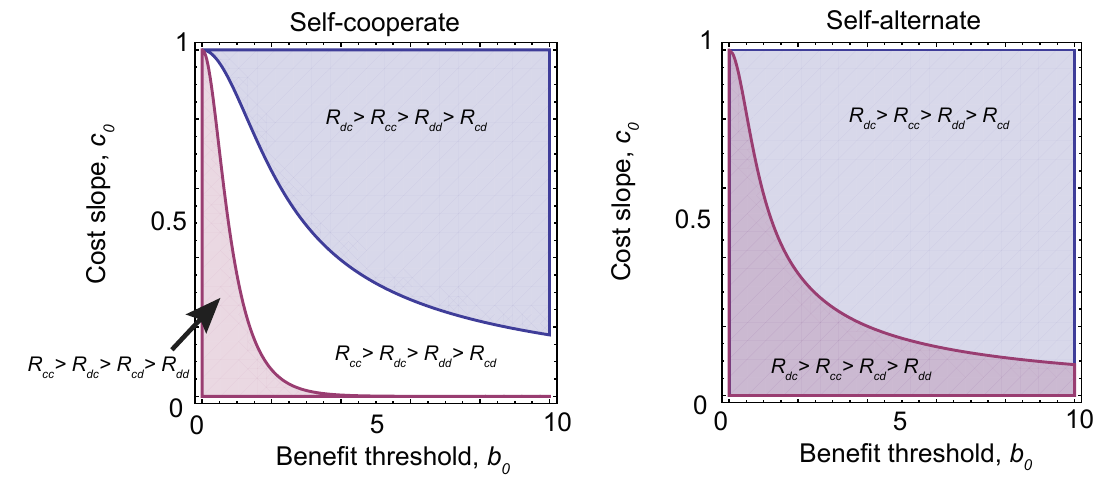
Figure 5. The evolution of different games. Under a sigmoidal benefit function (Equation (13)), different pairs of strategies and investment levels are robust (Equations (14) and (15)). Depending on the choice of threshold in the benefit function, b the rate of change of the cost of cooperation with investment, c slope of the sigmoid h = 4 ), this can result in different orderings of payoffs and, hence, different equilibrium games. (Left) The equilibrium games paired with self-cooperating strategies. The blue region has payoff ordering R a prisoner’s dilemma. However, in the white region R hunt game, and in the red region R self-alternate dominates, only two games are possible. The blue region is again a prisoner’s dilemma, while the purple region has R